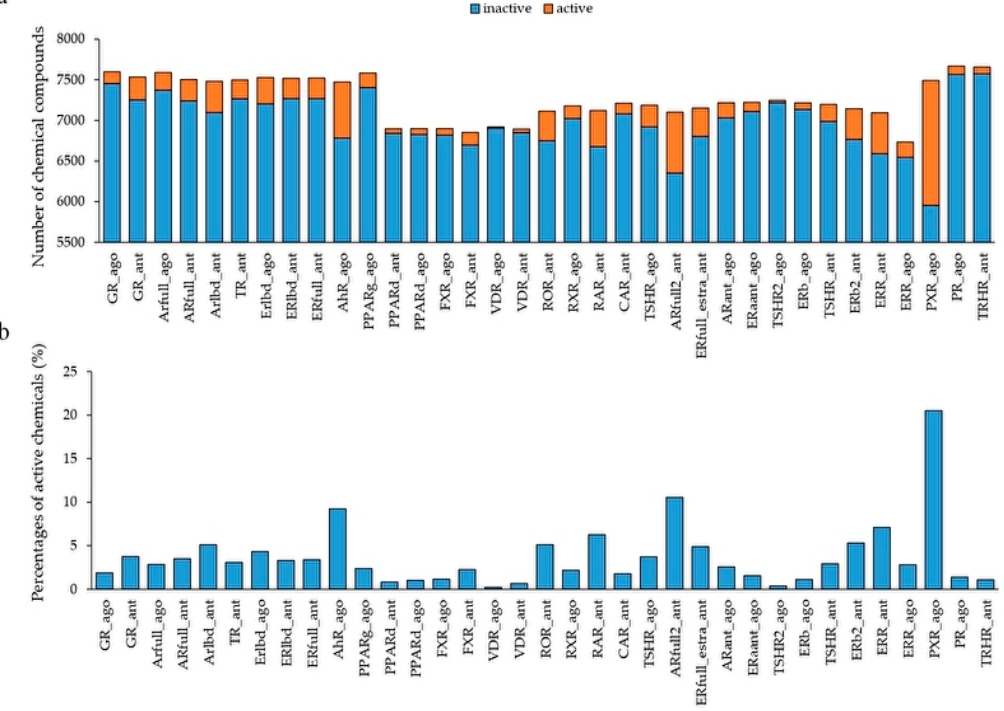
Figure 1. Activity distribution of the Tox21 10K library against 35 NR agonists and antagonists used in the DeepSnap-deep learning (DL) approach. ( a ) Number of chemical compounds used in the modeling by the DeepSnap-DL, where orange and blue indicate active and inactive chemicals, respectively. ( b ) Percentage of active chemicals against total chemicals.